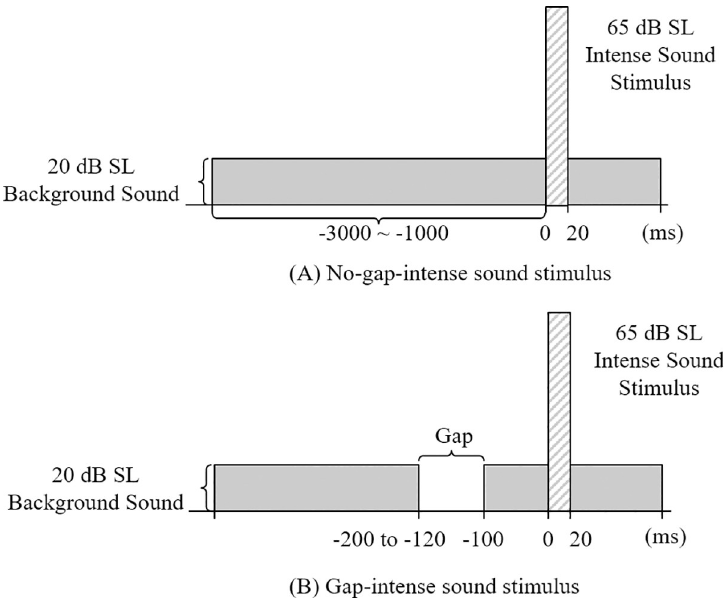
Fig 1. Diagrams of sound stimuli. (A) No-gap stimulus containing a background sound at an intensity of 20 dB SL (8 kHz pure tone) and a 20 ms long intense sound stimulus (1 kHz tone burst). (B) Gap stimulus containing a background sound at an intensity of 20 dB SL (8 kHz pure tone) and a 20 ms long intense sound stimulus (1 kHz tone burst). In addition, the stimulus was inserted with a silent gap (50 or 20 ms) 100 ms before the onset of the intense sound